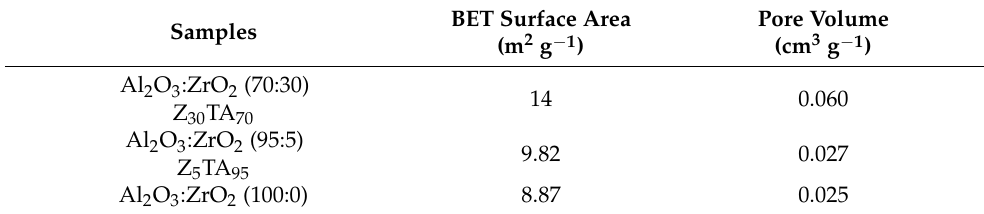
Table 1. The physical attributes of ZTA-based nanoparticles.